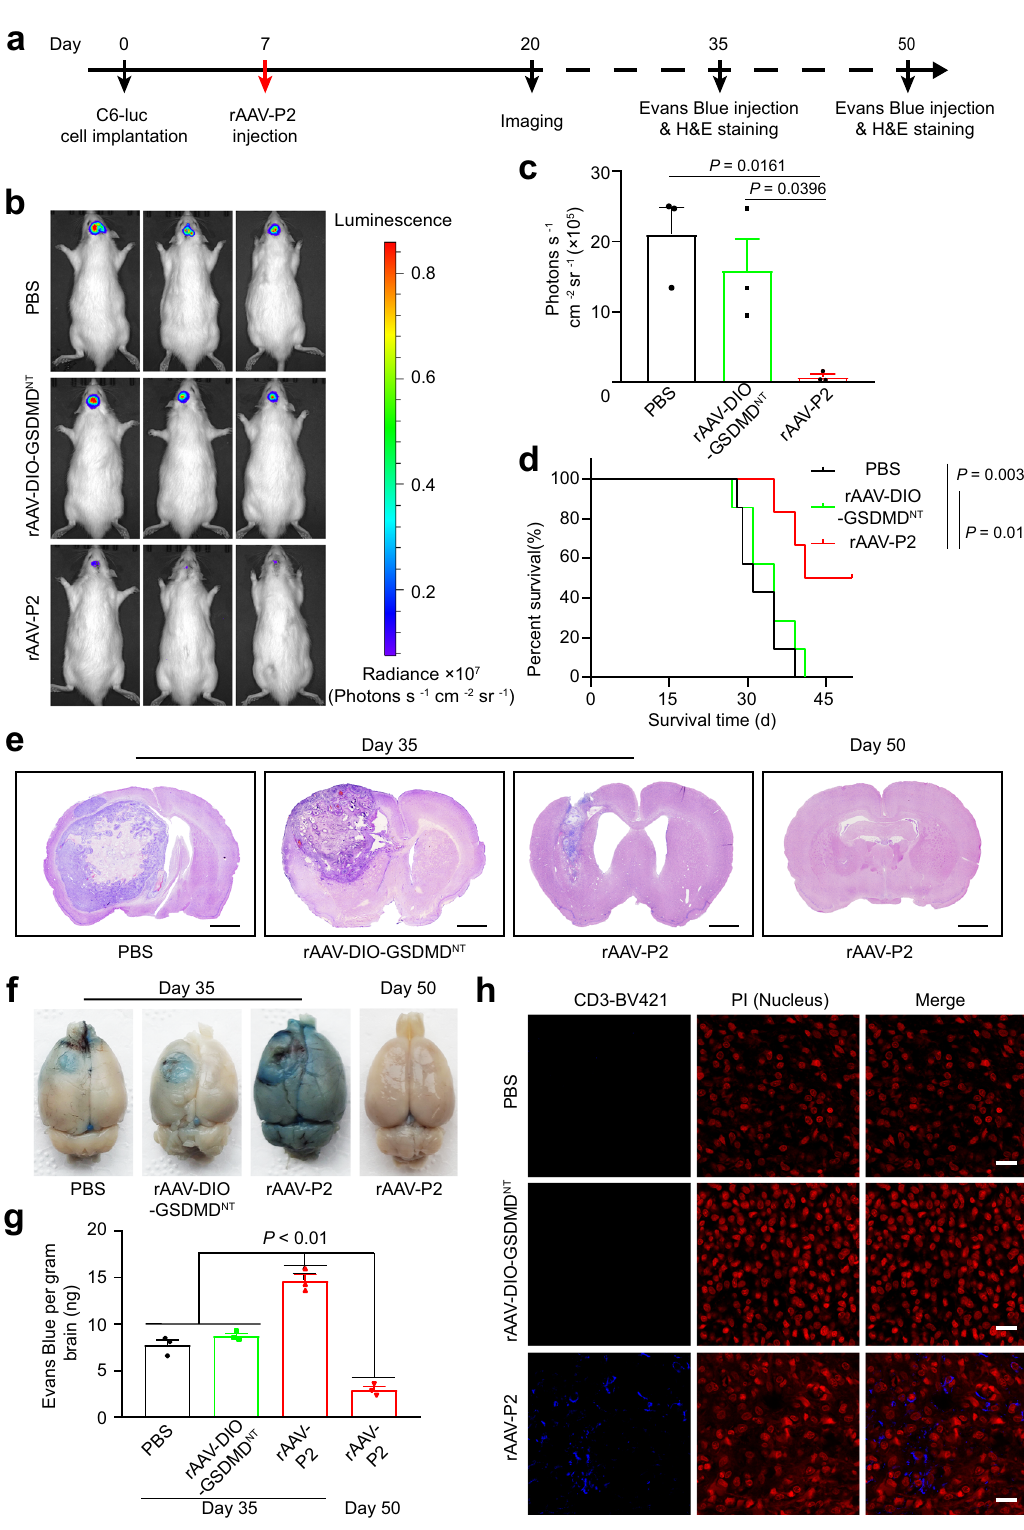
P2 treatment group and control group (Supplementary Fig. 10). CD8 + T cells to other cells was all increased (Supplementary Fig. 10). The expression analysis of the protumoral immunosup- pressive genes and proin fl ammatory chemokines in each cell cluster further supported the conclusion that rAAV-P2 treatment can enhance the antitumor immunity in the TME (Supplemen- tary Fig. 11). Of note, the athymic Nu/Nu mice TNBC model without mature T cells did not show tumor regression